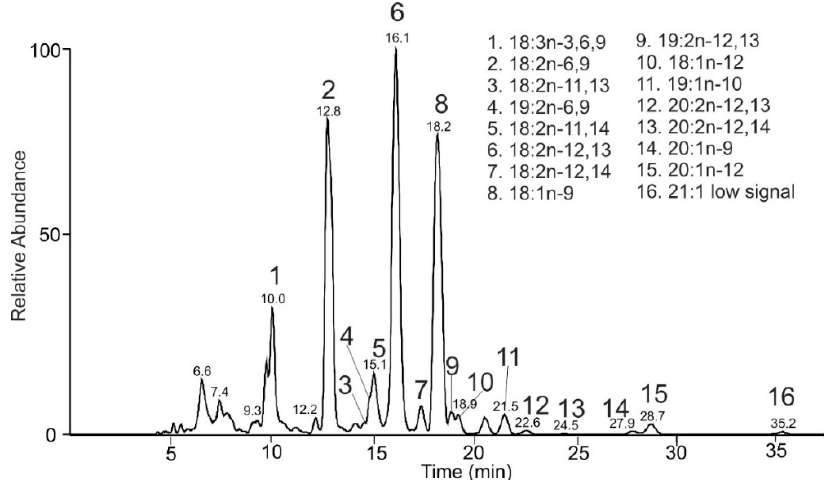
Figure 9. HPLC/APCI-MS base-peak chromatogram of FAMEs obtained from Marrubium vulgare seeds and the list of identified species.